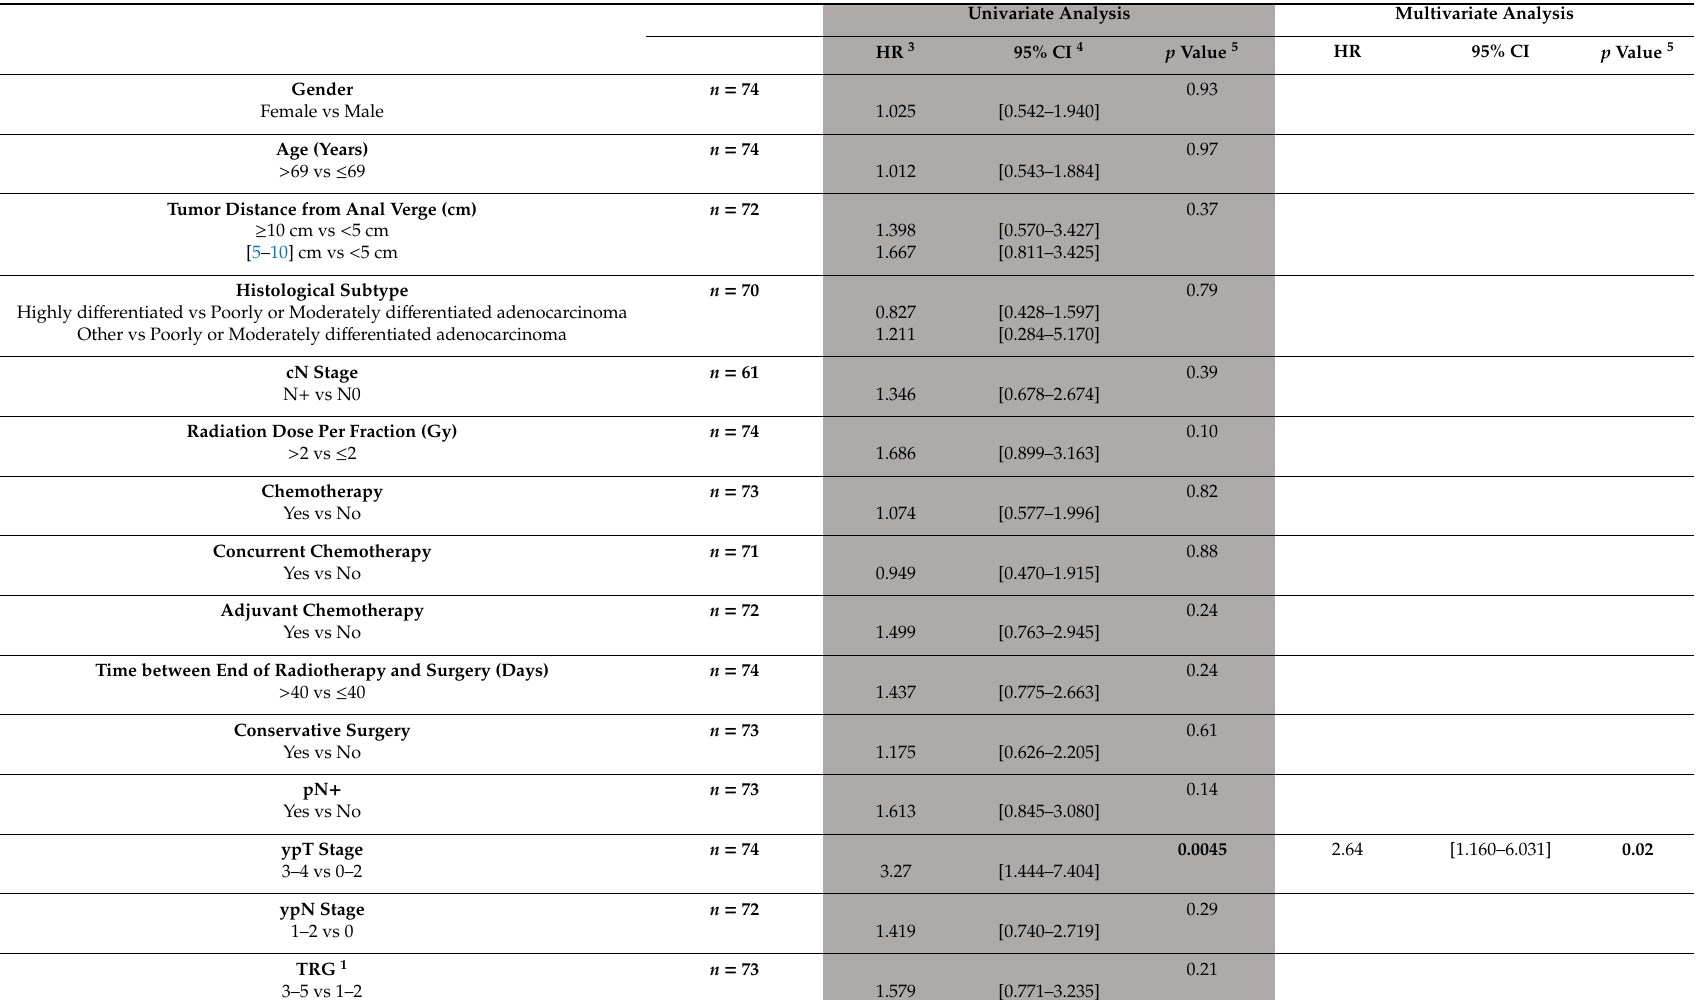
Table 4. Relation between clinical variables at baseline and after treatment and overall